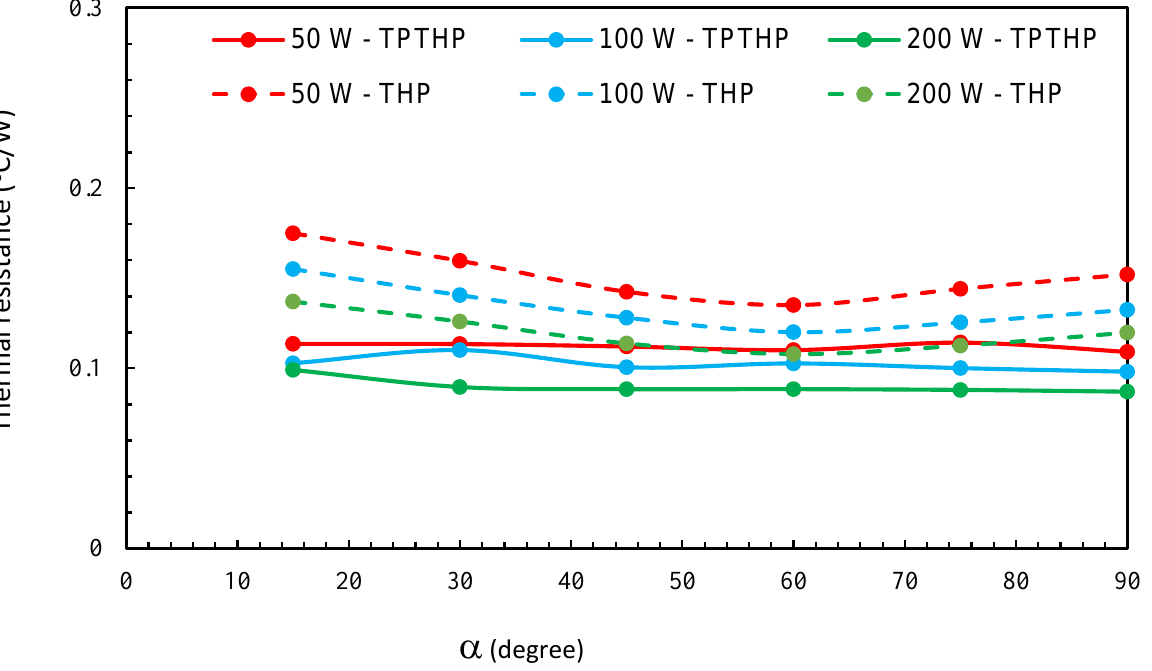
Figure 12. The variation of thermal resistance with inclination angle for the TPTHP and THP (FR = 55%).